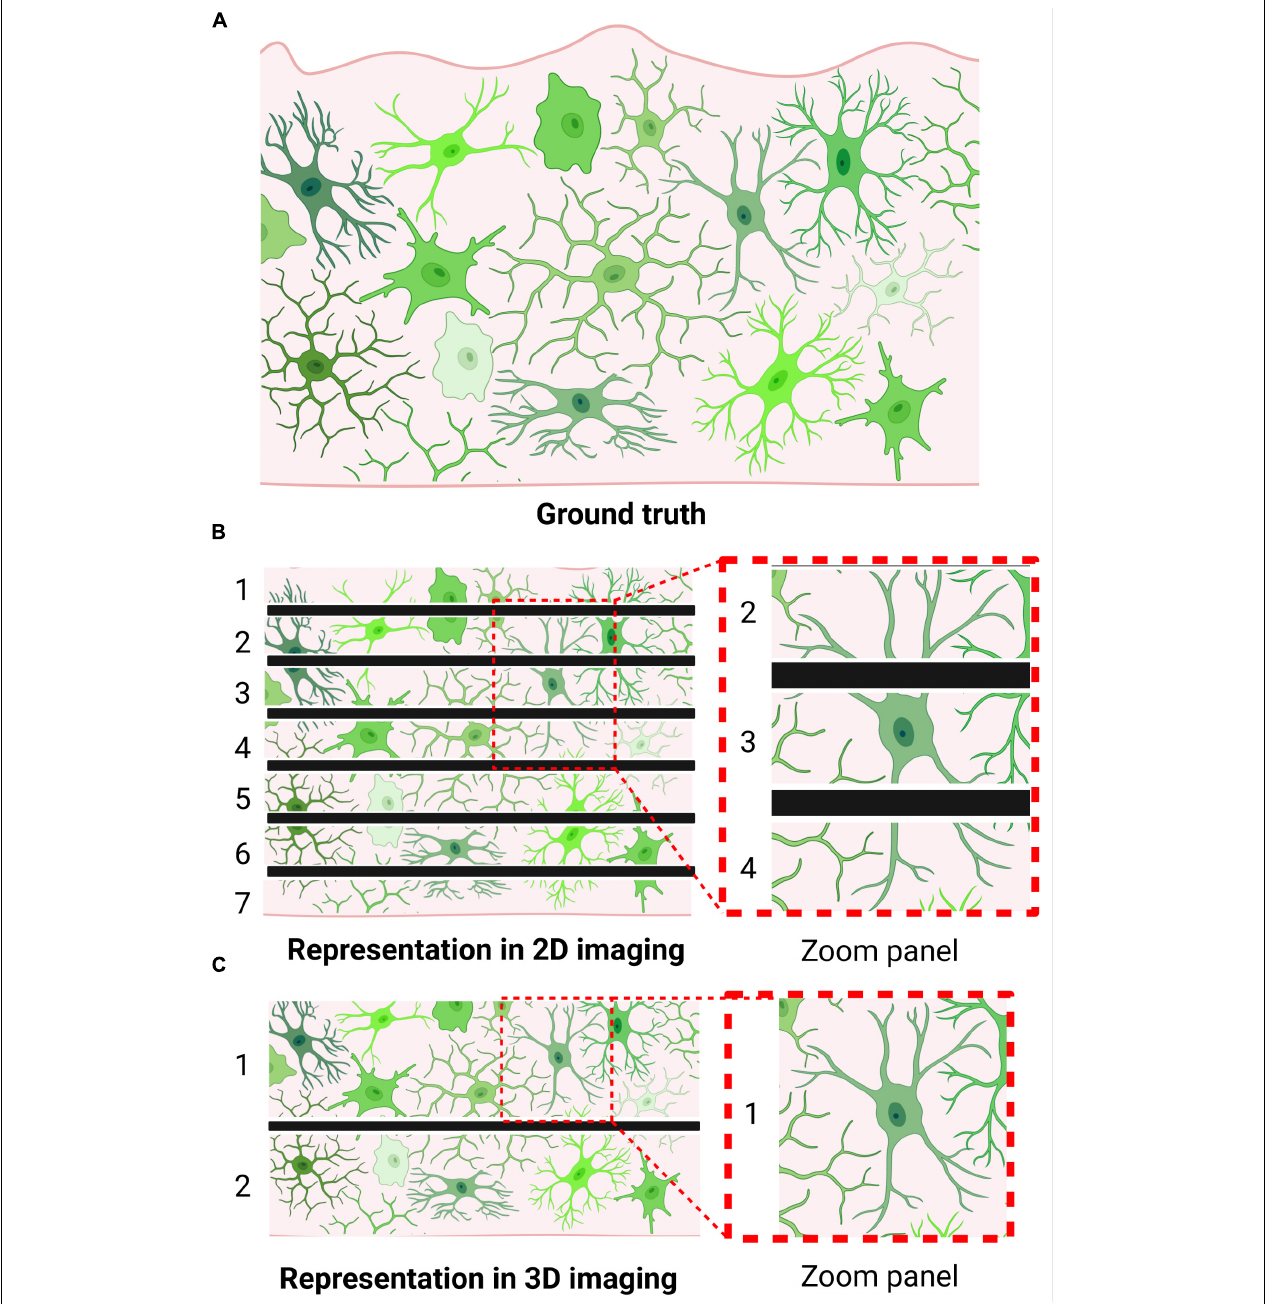
FIGURE 1 | Microglia may be morphologically misrepresented depending on imaging technique. (A) Brain tissue containing labeled microglia (i.e., visualization of ground truth). (B) Visualization of microglial morphology following thin sectioning, as required by 2D imaging approaches. Numbers indicate the number of sections produced; black bars indicate borders of obtained tissue sections. Zoom panel showcases a cell that could be misclassified as an activated microglia due to the method of sectioning. (C) Visualization of microglial morphology following thick sectioning, as permitted by 3D imaging approaches. Numbers indicate the number of sections produced; black bars indicate borders of obtained tissue sections. Zoom panel showcases the same cell as in panel (B) ; however, due to the thicker sectioning, its bipolar branch structure can be accurately represented.